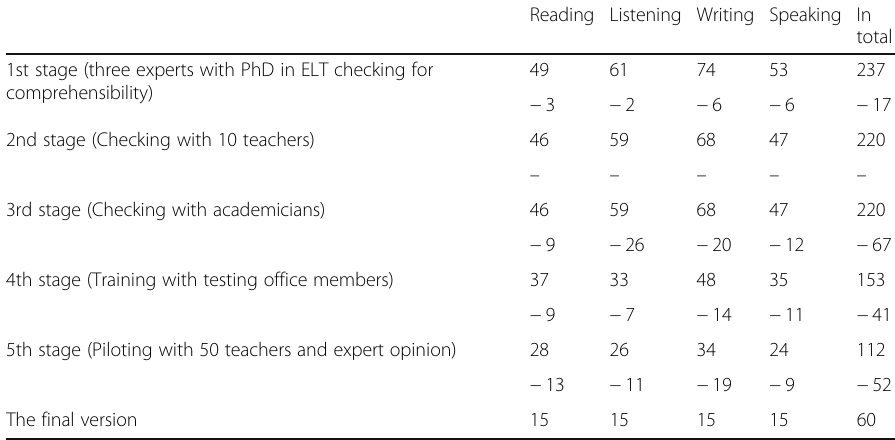
Table 2 The number of removed items throughout the validation process